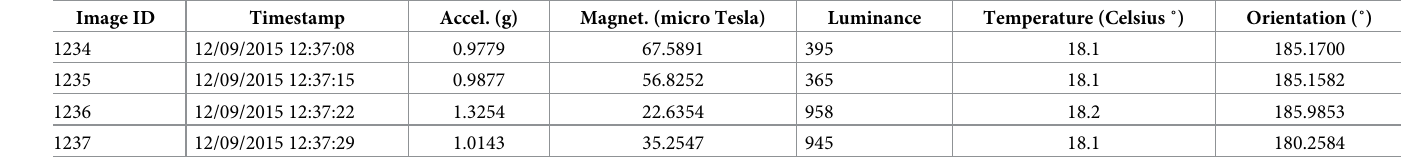
Table 2. Data structure for lifelogging dataset. Acceleration and magnetic field strength are calculated from initial sensor readings (Table 1). Image ID Timestamp